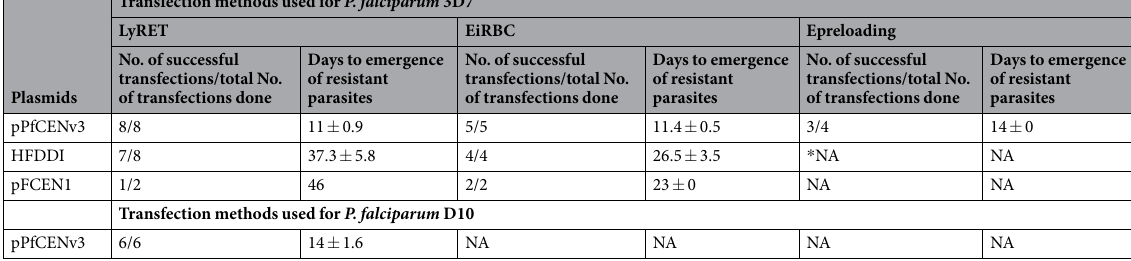
Table 1. Comparison of the success rate of transfection of P. falciparum by LyRET, Epreloading, and EiRBC methods. Each transfection experiment was independently performed. The days to emergence of resistant parasites is mean with SD of the days required for emergence of resistant parasites in successful experiments. * NA indicates “Not Attempted”.